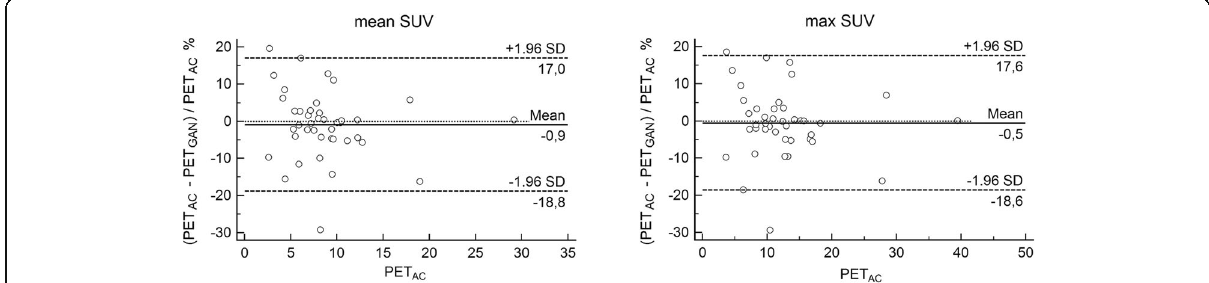
Fig. 6 Bland Altman plots comparing mean (left) and maximum (right) SUVs of PET AC and PET GAN of 41 focal areas of pathologic tracer